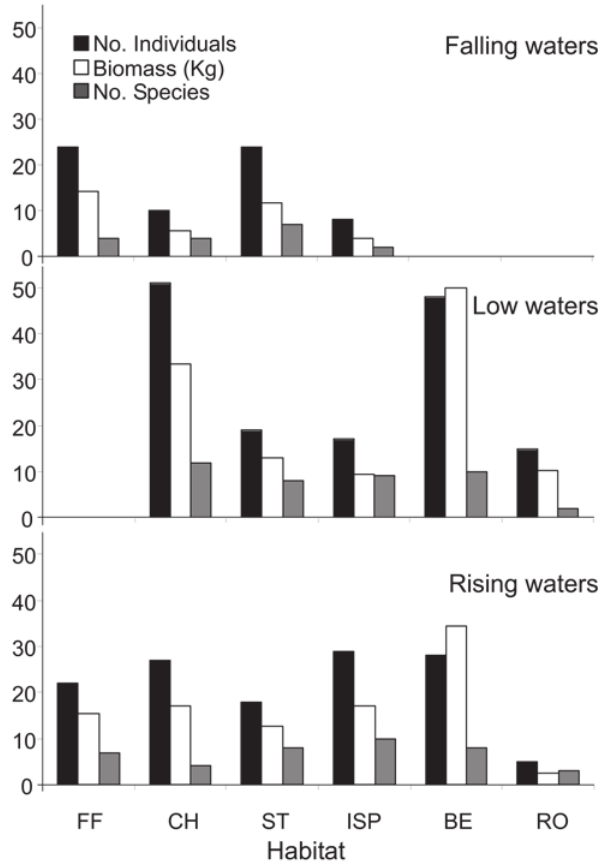
Fig. 2. Comparison of total abundance, biomass, and species richness among habitats, at three seasons in the Taraira Lake. Richness was expressed as total number of species collected in a habitat. Habitat names correspond to those in Table 2. Values represent fishes collected with the large gill net only.